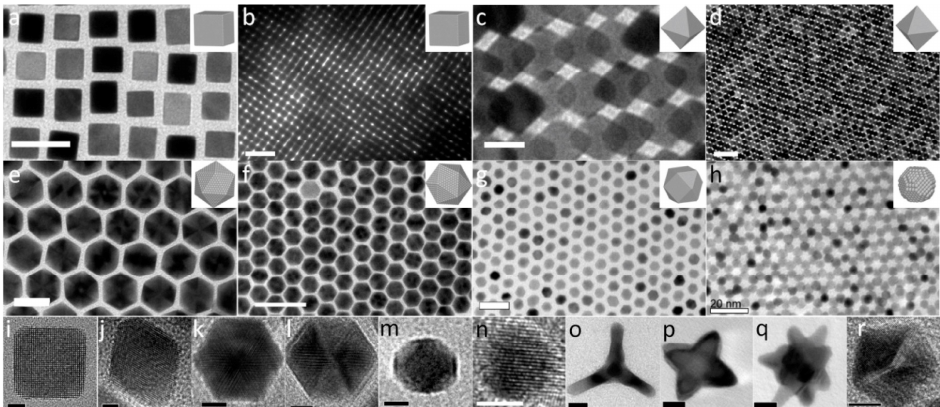
Figure 5. Pt NPs with different morphologies: ( a , b , i ) cubes, ( c , d , j ) octahedrons, ( e , f , k , l ) icosahedrons, ( g ) cuboctahedrons, ( b , n ) spheres, ( m ) truncated cube, ( o ) tetrapod, ( p ) star-like octapod, ( q ) multipod, ( r ) 5-fold twinned decahedron. Scale bars: ( a , e , g , h ) 20 nm, ( b , d , f ) 50 nm, ( c , o – q ) 10 nm, ( k , l – n , r ) 5 nm, ( i , j ) 2 nm. Reproduced from Ref. [98] with permission from American Chemical Society, copyright 2013.